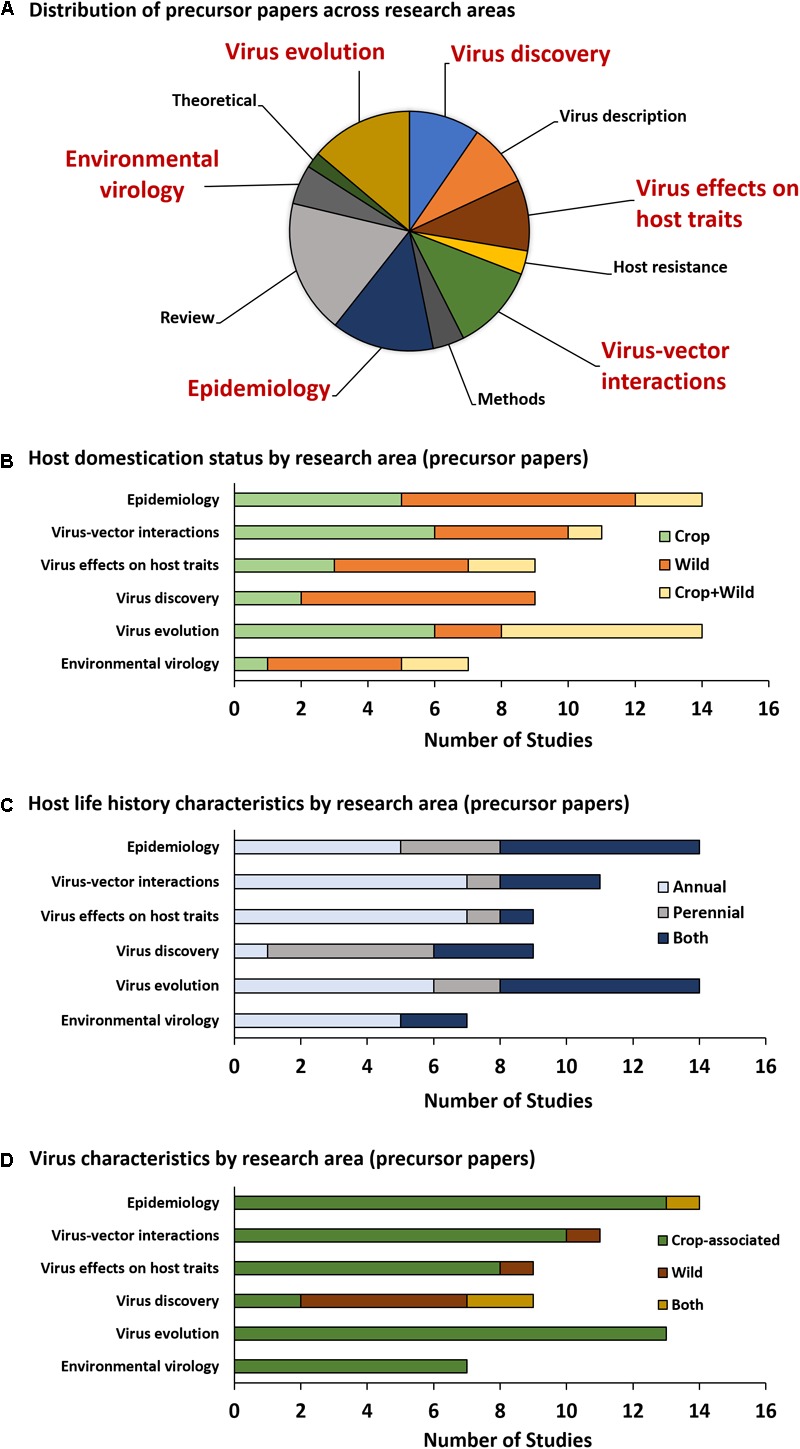
Precursor paper research topic categories. The pie graph (A) illustrates the proportion of precursor papers (direct outputs of PVEN) falling into each category. The six categories most relevant to the field of virus ecology are emphasized in large, red text. Graphs (B–D) summarize the number of studies utilizing hosts and viruses with specific categorical characteristics.